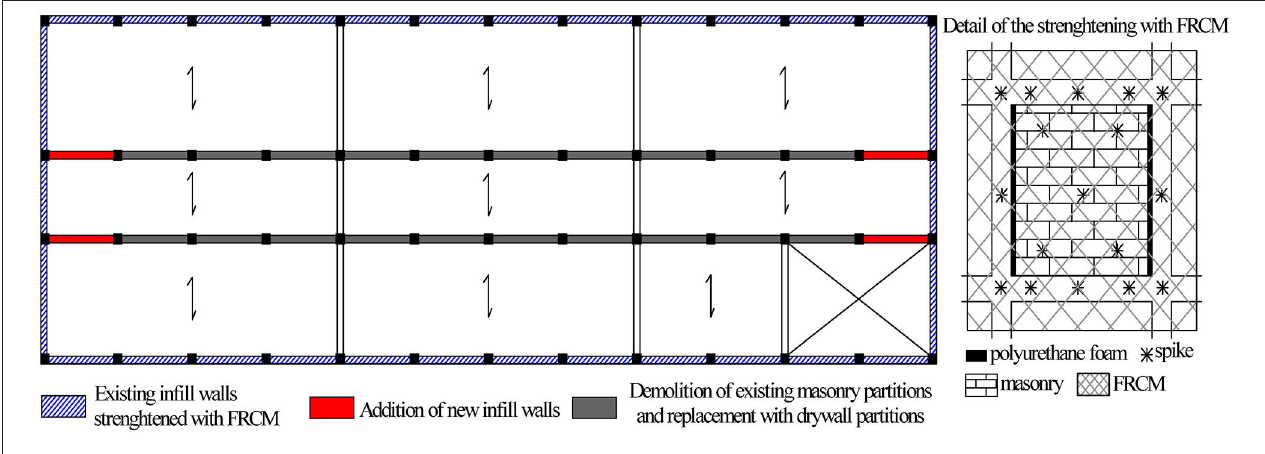
FIGURE 9 | Proposed retrofitting solution.